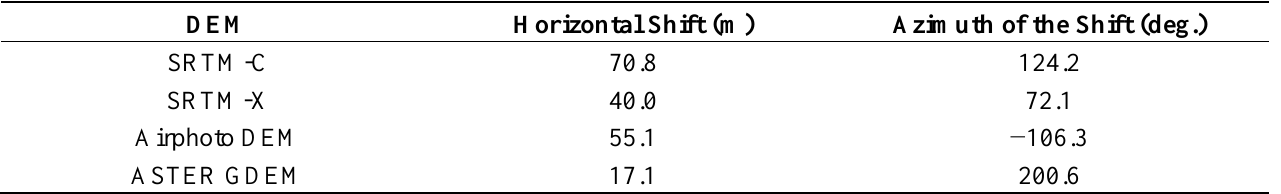
Table 1. Horizontal shifts of the reference DEMs with respect to the ICESat measurements which had to be removed before the extraction of ΔH